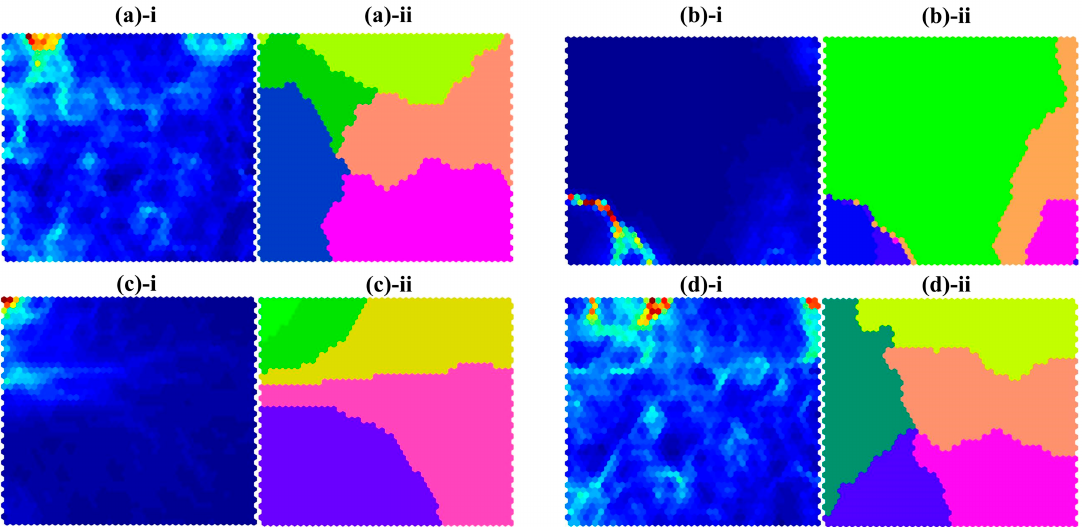
Figure 6. Results of self-organizing map (SOM) analysis. Each hexagon represents the neuron generated by the completive learning process. ( a )- i , ( b )- i , ( c )- i , and ( d )- i represent the neuron map trained by SOM. ( a )- ii , ( b )- ii , ( c )- ii and ( d )- ii represent the clustered neuron map made by the k-means clustering method ( k = 5) using neuron maps. ( a ) HRV features; ( b ) SC features; ( c ) SKT features; and ( d ) IT